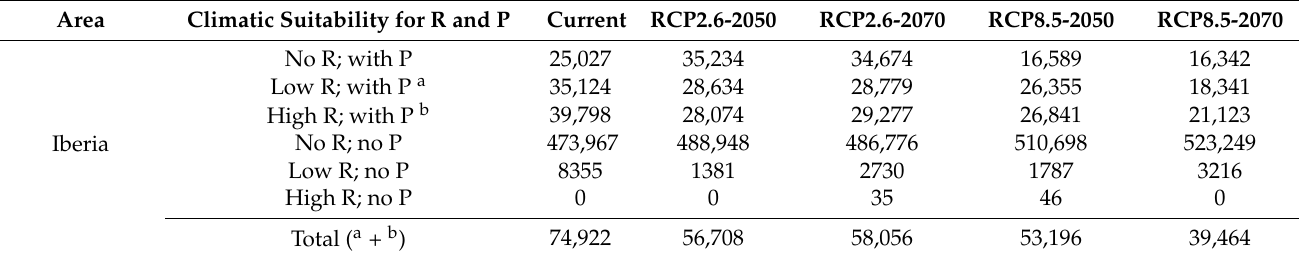
Table 7. Areas (km 2 ) in the Iberian Peninsula and inside the Natura 2000 network according to the combination of climatic suitability for Eucalyptus globulus recruitment (R) and plantations (P) in current and future times in the years 2050 and 2070 under climate change scenarios RCP2.6 and RCP8.5 1